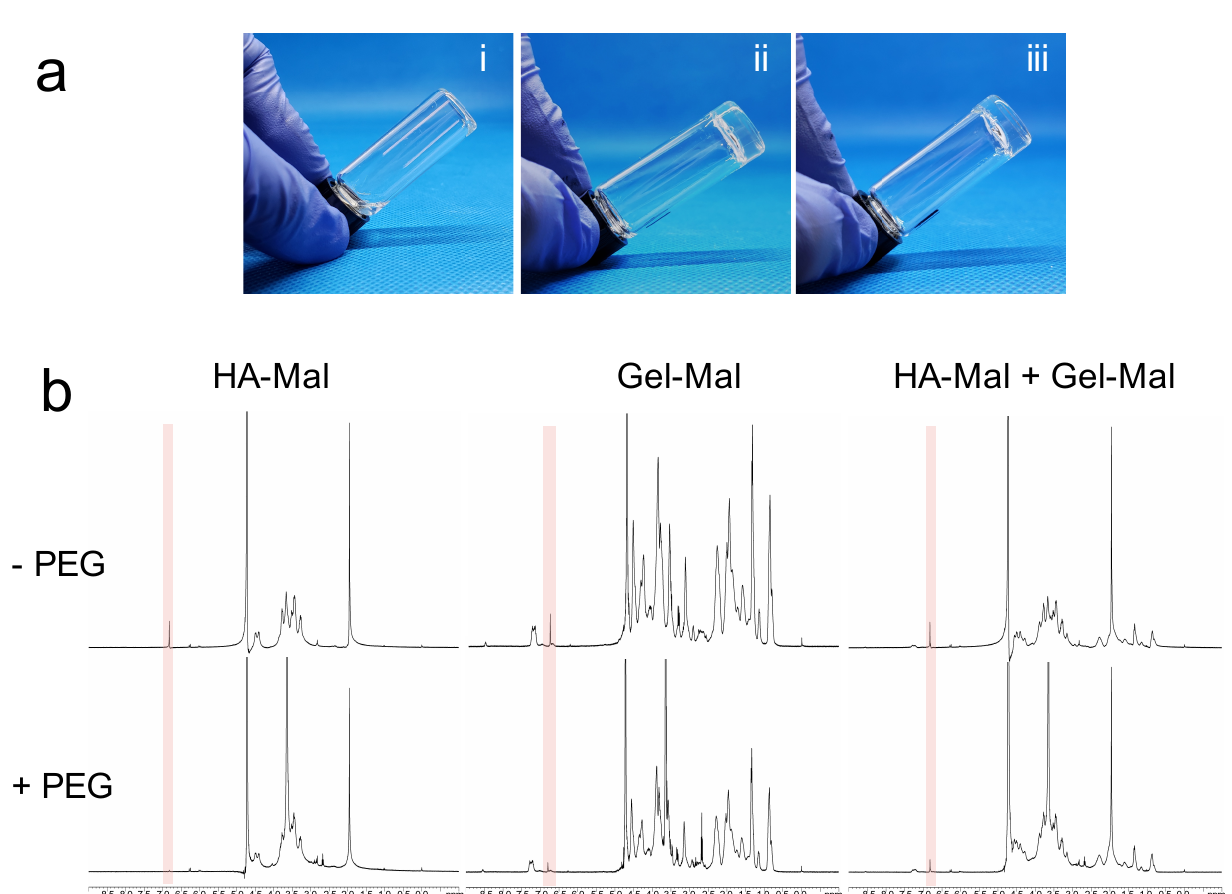
Figure 4. Gelation Testing with HA-Mal, Gel-Mal, and PEGDSH. ( a ) Visual gel formation of hydrogel (i) without PEGDSH crosslinker (ii) HMGM 1 (iii) HMGM 2. Materials crosslinked in <5 s. ( b ) 1 H NMR spectrum of HA-Mal with PEGDSH (left), Gel-Mal + PEGDSH (middle), and HA-Mal + Gel-Mal + PEGDSH (right). The maleimide peak is reduced or eliminated at 6.8 ppm (pink highlighted regions) with the addition of the PEG crosslinker.